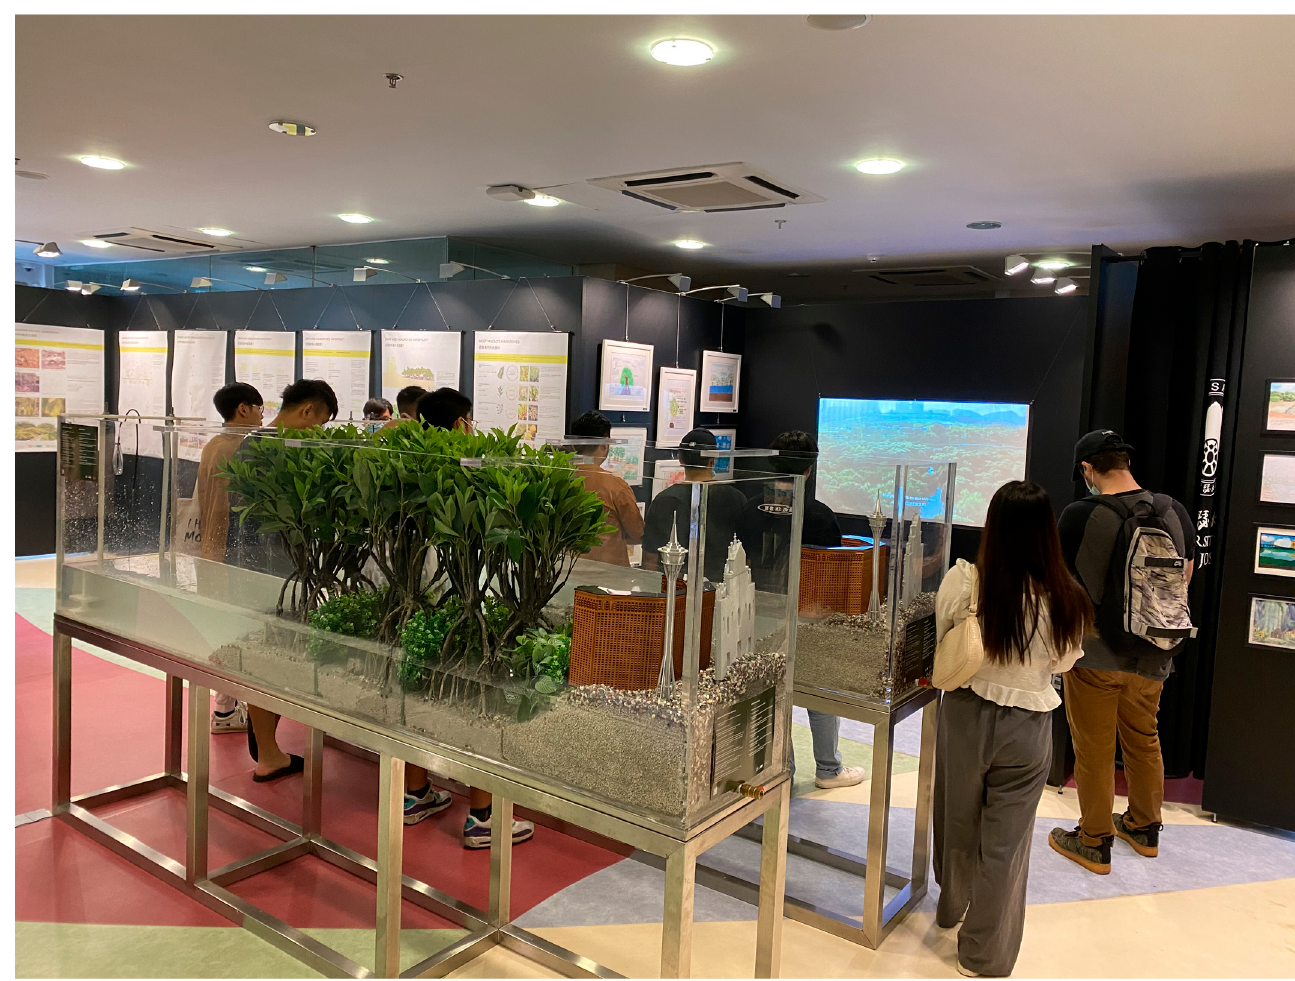
Figure 1. Students viewing the mangroves-related materials at the exhibition